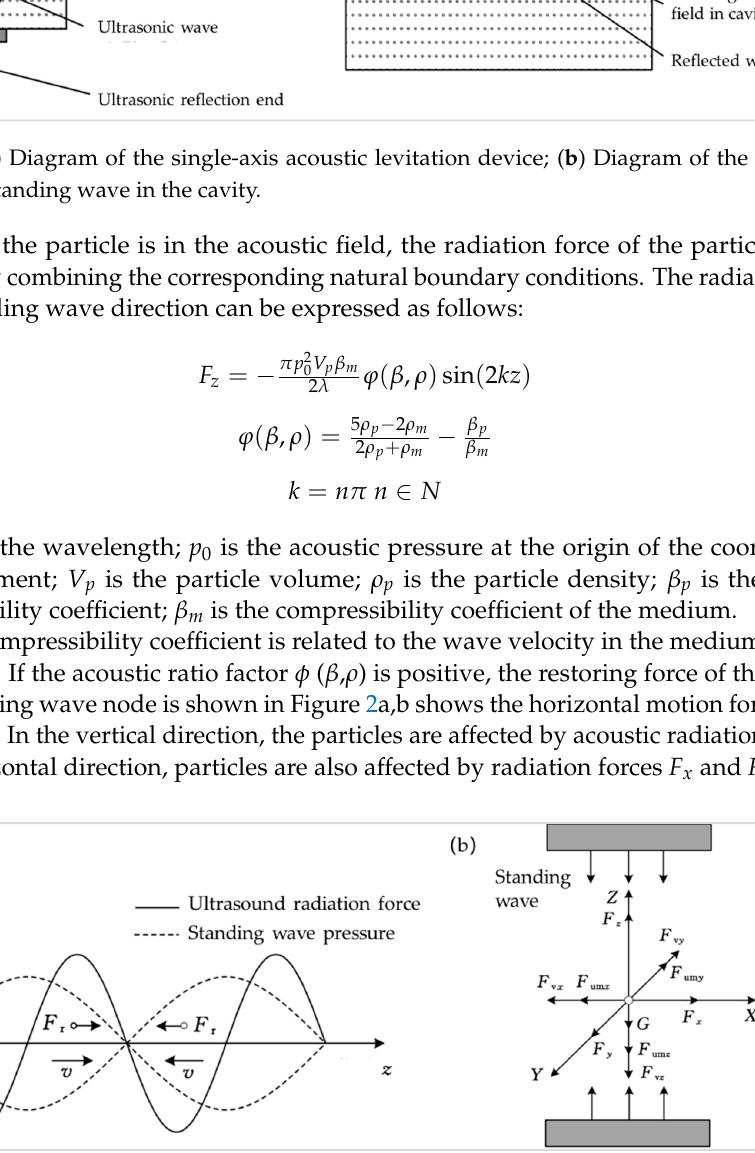
Figure 2. ( a ) The force diagram of particles in a one-dimensional ultrasonic standing wave field; ( b ) Diagram of the Force Model of Particle Horizontal Motion.